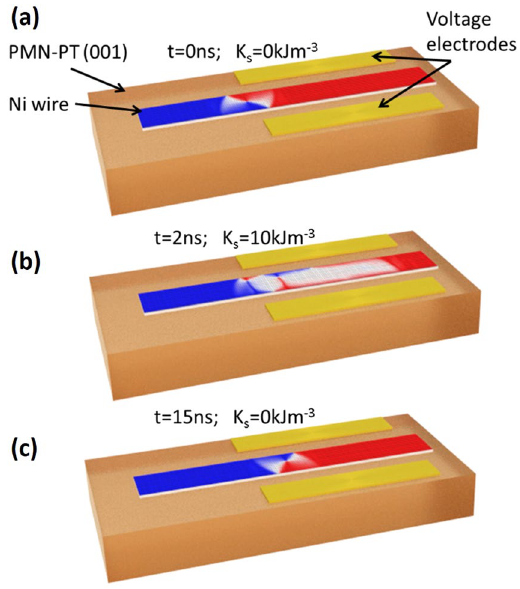
Figure 4. A method to switch the chirality of a vortex domain wall by applying strain locally. A schematic representation of a device element for reversing the chirality of a vortex domain wall in a nanowire fabricated on a piezoelectric substrate. A voltage applied to the electrodes induces a mechanical strain and a uniaxial anisotropy favouring an easy axis transverse to the wire. ( a ), A vortex domain wall positioned at the edge of the electrode region is transformed to a flux closure domain pattern near the electrodes ( b ). ( c ), Relaxation of the induced anisotropy leads to the formation of a vortex domain wall with the opposite chirality to the initial domain